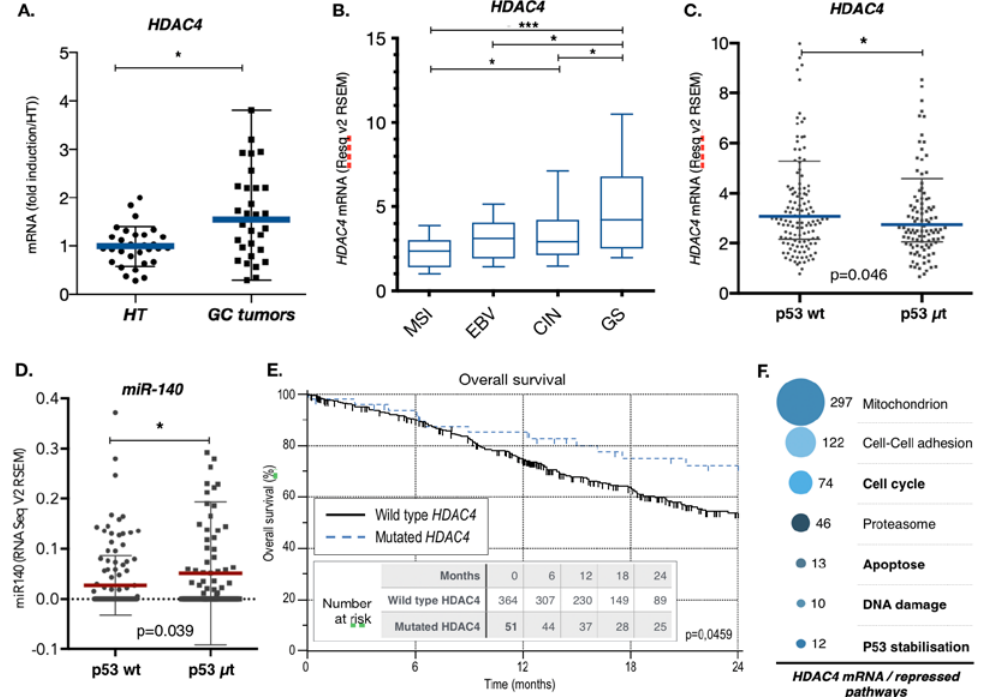
Figure 4. HDAC4 expression and role in gastric cancer patient survival. ( A ) Expression level of HDAC4 in gastric cancers. RNA was extracted from gastric cancer biopsies and adjacent healthy tissue samples obtained from the CARDIA collection of the HUS, Strasbourg. RT-qPCR for HDAC4 was performed and the results were normalized against TBP and G3PDH. The graph represents medians with ranges ( n = 26). p < 0.0069, paired t -test. ( B ) HDAC4 expression level in the gastric tumors of the TCGA based on the molecular subgroups. Expression data for HDAC4 in gastric tumor were extracted from the TCGA data library and analyzed based on the molecular subgroups (MSI n = 58; EBV n = 24, CIN n = 126, GS n = 50). The graph represents mean with 5–95 percentile. *** when p < 0.001, * when p < 0.05 as determined by ANOVA followed by a Tukey post-test. MSI = microsatellite instable; EBV = Epstein Barr virus; CI n = Chromosome Instable; GS = Genetic stable. ( C , D ) miR-140 and HDAC4 expression level in the gastric tumors of the TCGA based on the p53 mutational status. Expression data for miR-140 and HDAC4 in gastric tumor were extracted from the TCGA data library and analyzed based on the mutational status of p53, either wild type (p53 wt n = 141) or mutated (p53 µ t n = 117). The graph represents mean with standard deviation and analyzed by ANOVA followed by an unpaired t -test. ( E ) Kaplan–Meier analysis of patients’ overall survival of the 379 patients with wildtype HDAC4 and 36 patients with either mutated or deleted HDAC4 and stratified according to HDAC4 mutational status: 0 = no mutation, 1 = mutation or deletion. Mutation or deletion of HDAC4 was a predictor of tumor recurrence ( p = 0.0383). ( F ) Deregulated signaling pathways and cellular processes that correlated negatively with HDAC4 expression in gastric cancer data of the TCGA. Gene expression data of gastric cancer tumors from the TCGA were analyzed to identify genes with an expression that correlates negatively (Pearson correlation coe ffi cient < − 0.3) with the expression of HDAC4 (cBioportal.com). Then, the list of genes was subjected to unsupervised pathways analyses (DAVID: https: // david.ncifcrf.gov; https: // reactome.org). The graph represents the most relevant deregulated